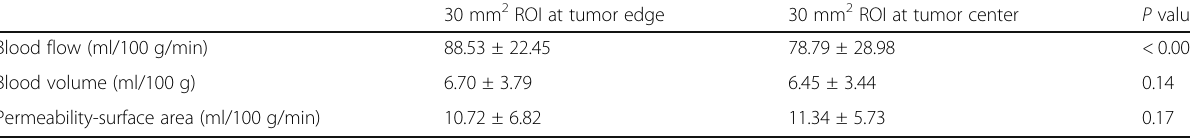
Table 3 Perfusion parameters of colorectal cancer at the tumor edge and at the tumor center using 30 mm 2